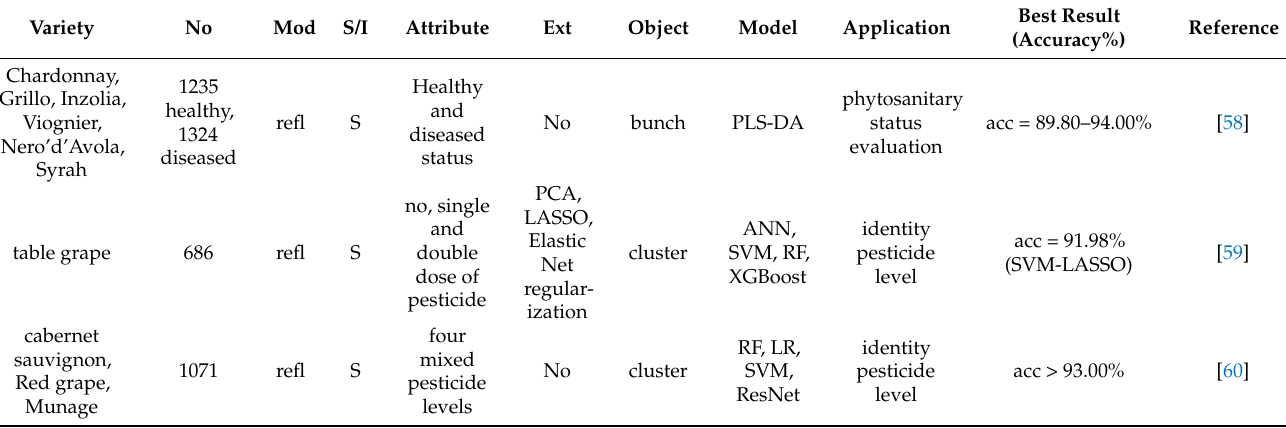
Table 4. Safety inspection of NIRS and HSI in